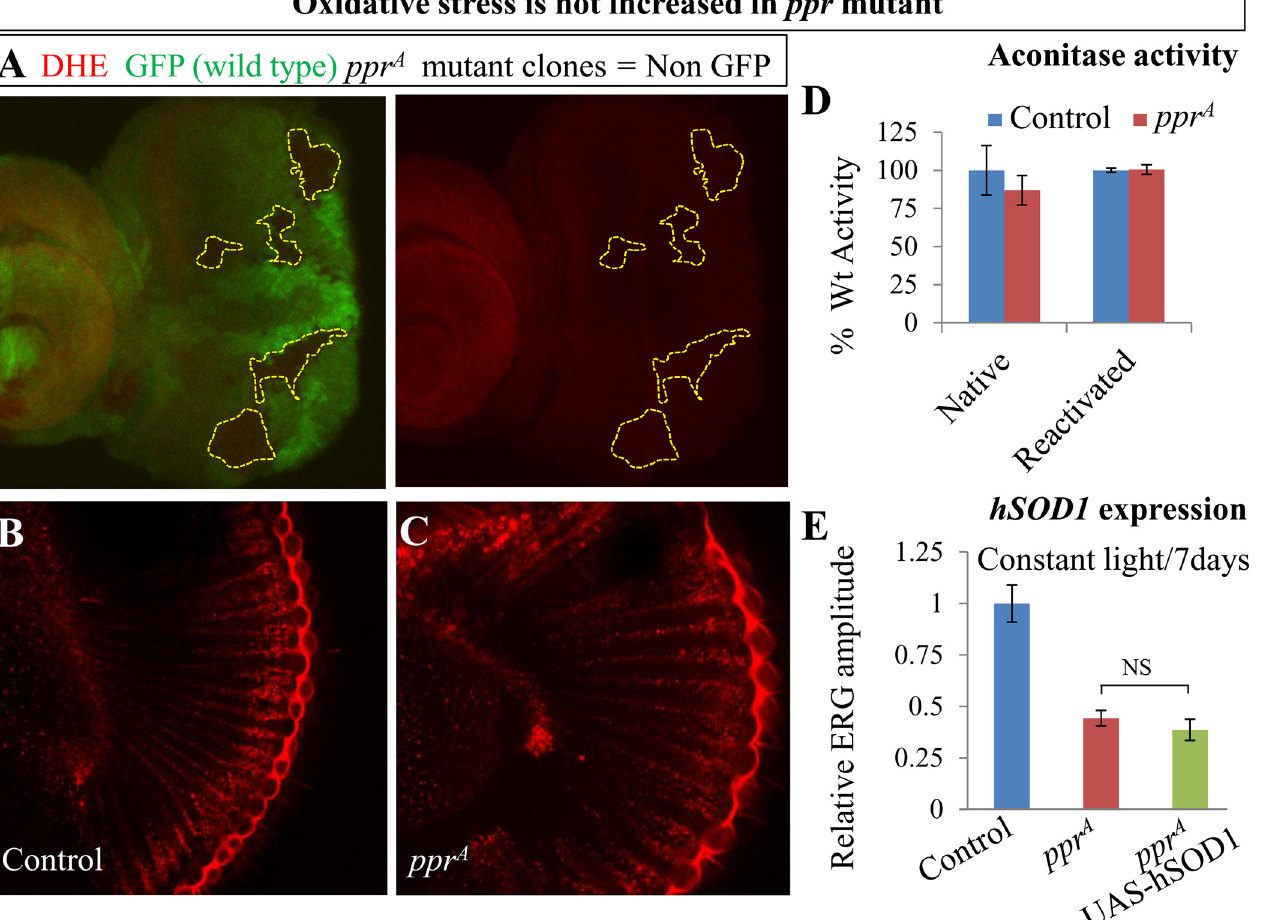
Fig 8. PR degeneration is not induced by oxidative stress in ppr mutants. (A – C) Detection of ROS levels by DHE (red) staining in ppr mutant clones in eye imaginal discs. Mutant clones, encircled by dotted lines, are marked by loss of GFP (green). (B, C) Detection of ROS levels by DHE staining (red) in control (B) and ppr mutant (C) eyes from adult flies exposed to 24 h light (1,800 Lux). (D) Aconitase activity, which is negatively correlated to ROS levels because of its sensitivity to oxidation, is measured in mitochondrial extracts from third instar larvae (Native) or upon treatment with a reducing agent (Reactivated) to control for variations in the total amount of enzyme. Error bars represent ± SD. (E) Relative ERG amplitude from retinas of control, ppr A and ppr A expressing hSOD1 in R1-R6 using Rh1-Gal4. All flies carried Rh1-GAL4 in this experiment. Flies were raised in constant light for seven days. Error bars represent ± SEM; NS (two-tailed Student ’ s t test not